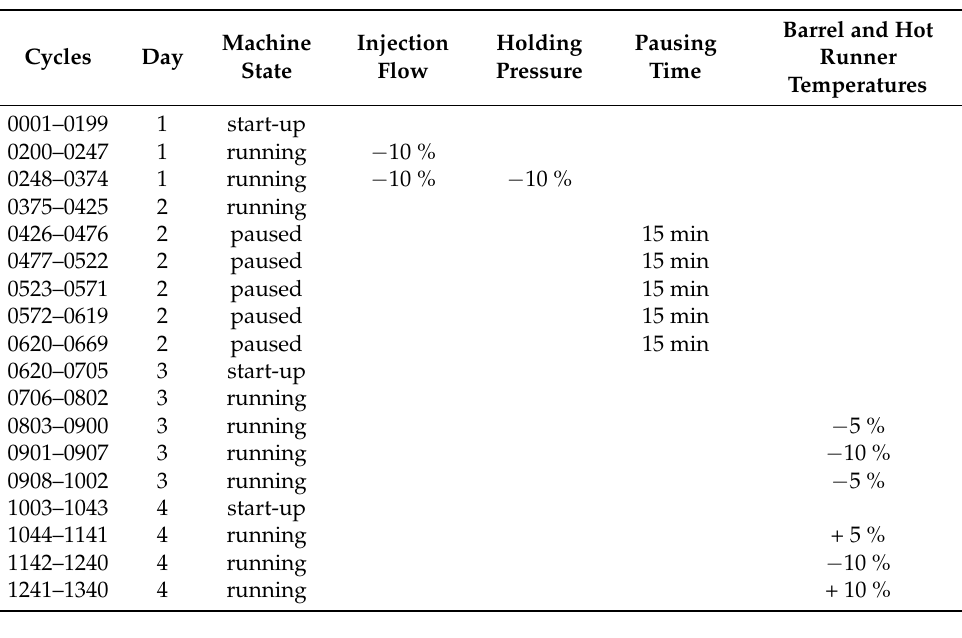
Table 3. Varied parameters for Stacking Box II dataset.